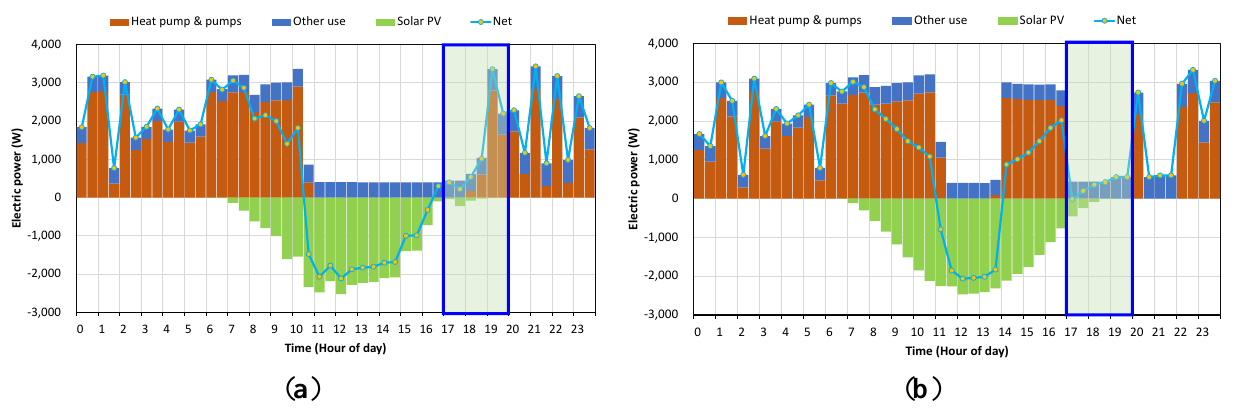
Figure 11. Electricity consumption for different control strategies ( a ) CC and ( b ) CSC in space-heating operation mode